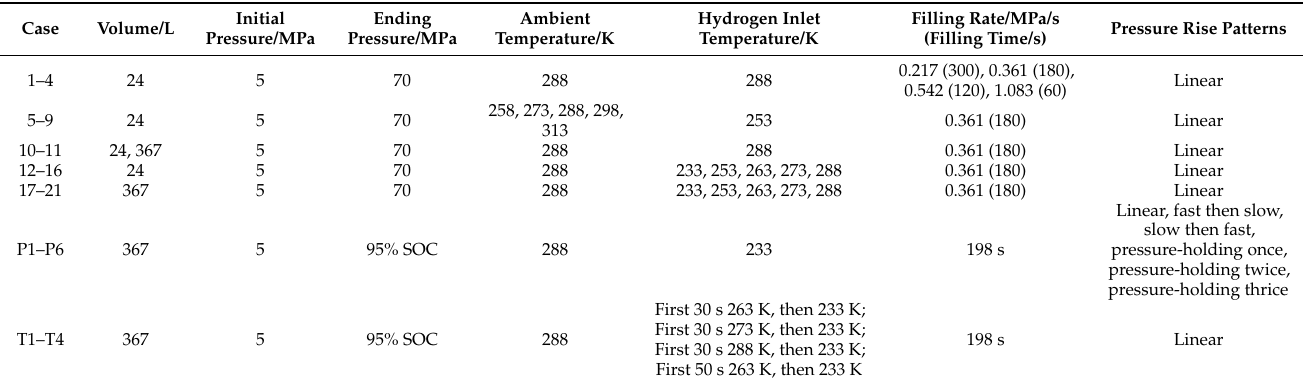
Table 4. Filling parameters for the considered